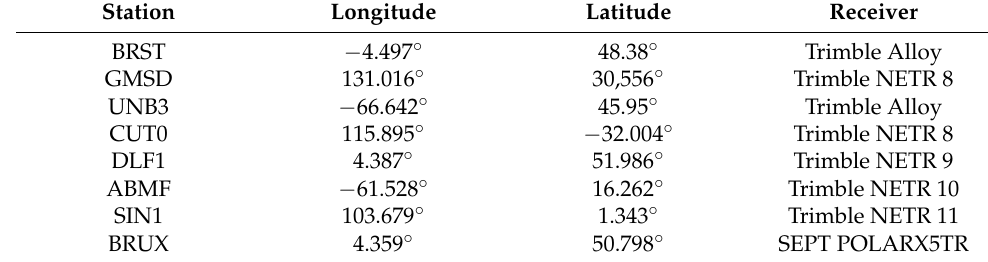
Table 1. Properties of examined stations.